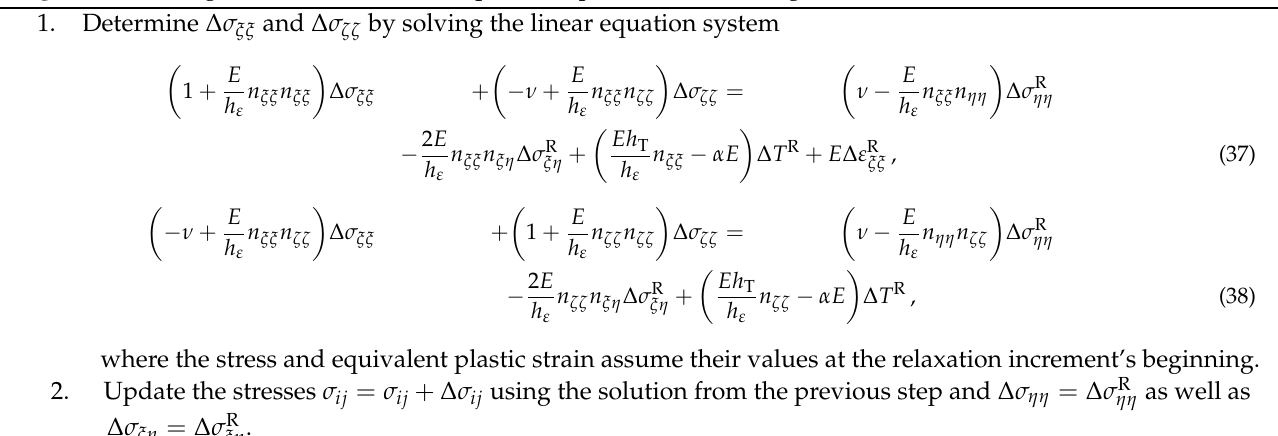
Algorithm 3: Integration of stresses and equivalent plastic strain during